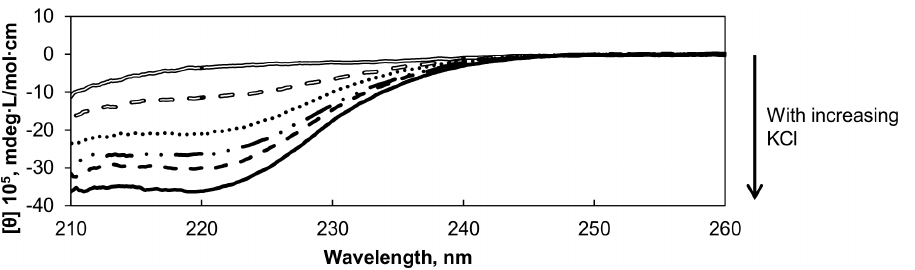
Figure 2. Circular dichroism spectra of NRC-1 CysRS in increasing concentrations of KCl. The CD spectra from 210 to 260 nm of NRC-1 CysRS in various concentrations of KCl. As the KCl concentration increases, the CD signal increases. The KCl concentrations are as follows: 50 mM (open line), 100 mM (open dash), 150 mM (dotted line), 200 mM (dash dot line), 1 M (solid dash), 2 M (solid line).